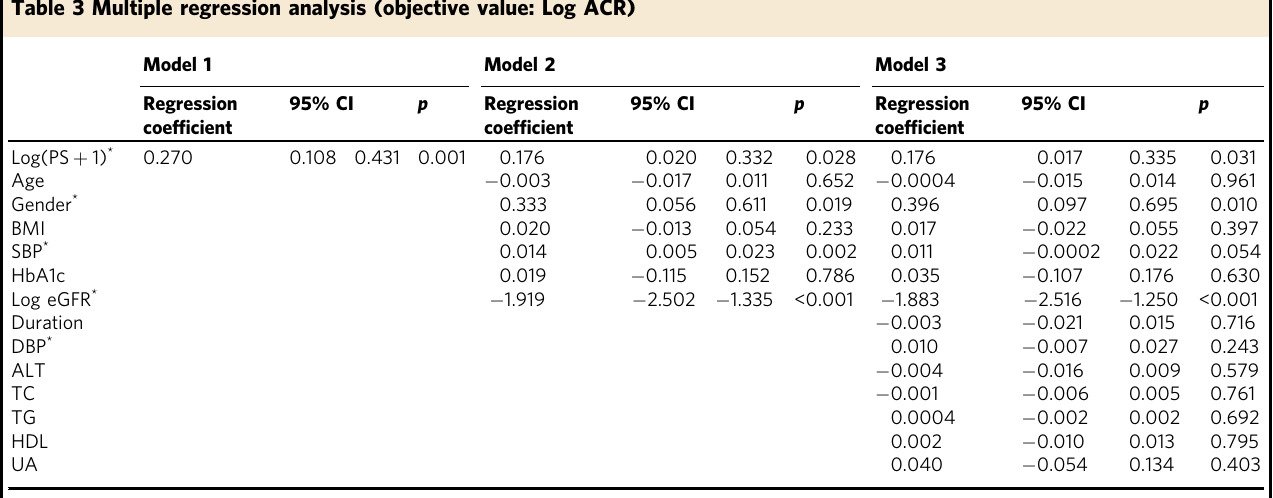
Table 3 Multiple regression analysis (objective value: Log